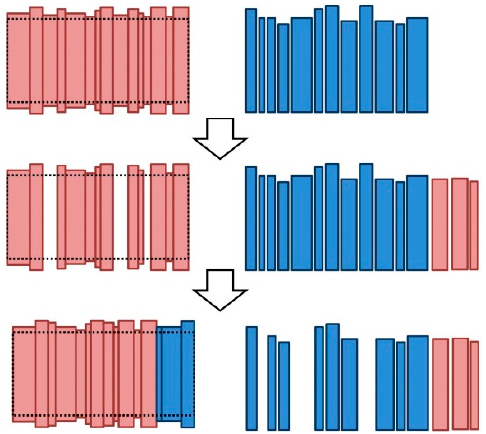
Figure 4. Procedure for applying the mutation operator to a body. First, several staves of the original body, which are represented in red, are randomly chosen and removed from the body. Then, a set of staves that are not used in this body, which are represented in blue, are chosen to replace the removed staves while checking that the total width of the new body is of the considered dimensions. The number of staves that are represented in this figure is lower than is typical in a real body (approximately 30) to improve the visibility.